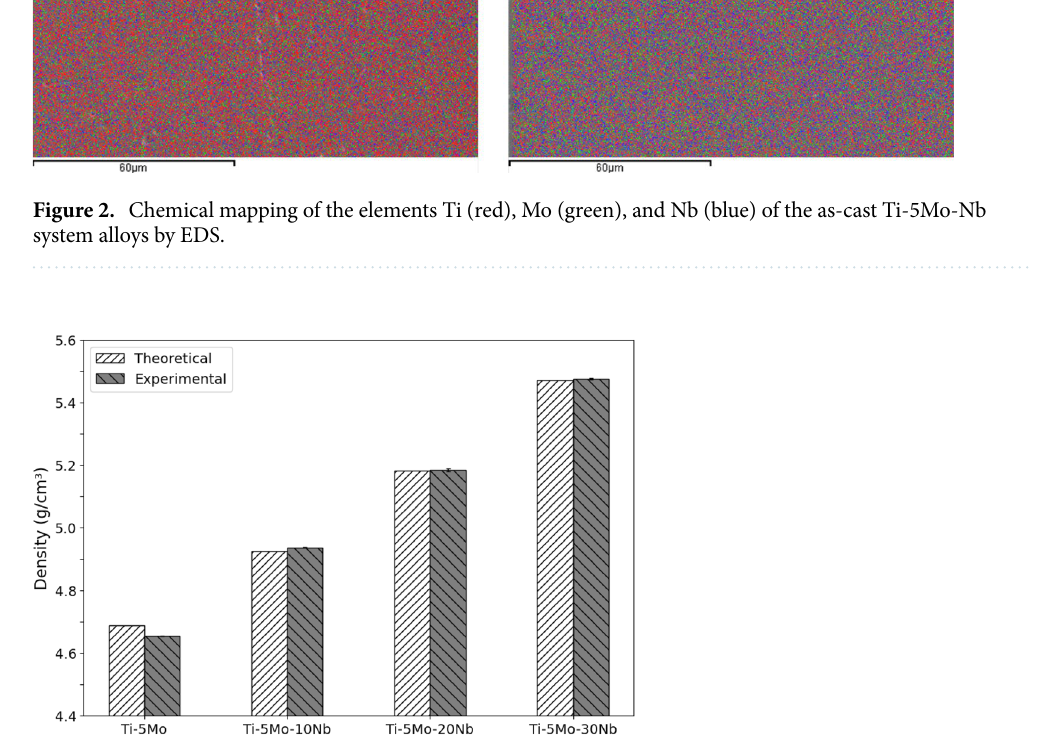
Figure 3. Comparison between the theoretical and experimental densities of the Ti-5Mo-Nb system